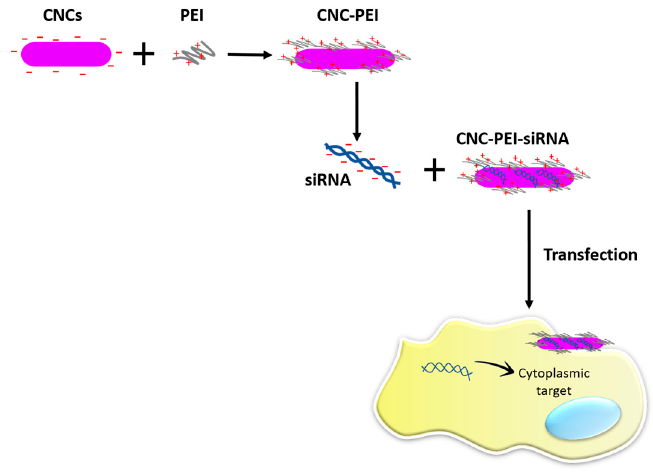
Figure 11. General procedure for the synthesis of CNCs-PEI-siRNA complexes and siRNA targeting in cells. Redrawn from ref [126].